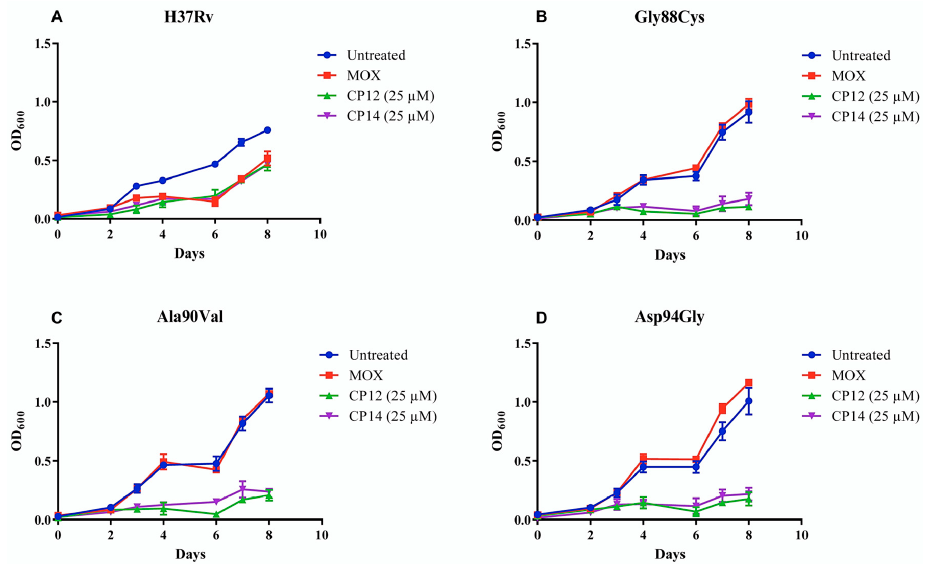
Figure 4. Preliminary evidence of maintained activity of CM12 and CM14 in fluoroquinolone sensitive ( A : H37Rv) and resistant M. tuberculosis ( B , C , and D : Gly88Cys, Ala90Val, and Asp94Gly, respectively). Moxifloxacin (MOX) was used at a concentration of 1.2 µM. OD 600 : optical density measured at 600 nm.